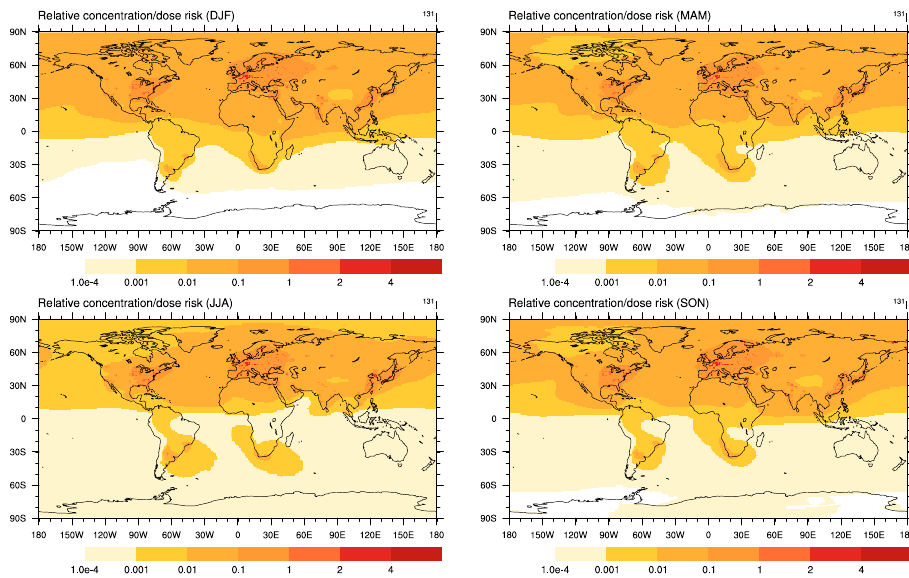
Fig.3. Relativeriskofseasonaltotal(includesoperational,underconstruction, plannedpowerplants) 131 I meansurfacelayerconcentration, and equivalent effective dose to the public from inhalation, averaged over the years 2010–2030.